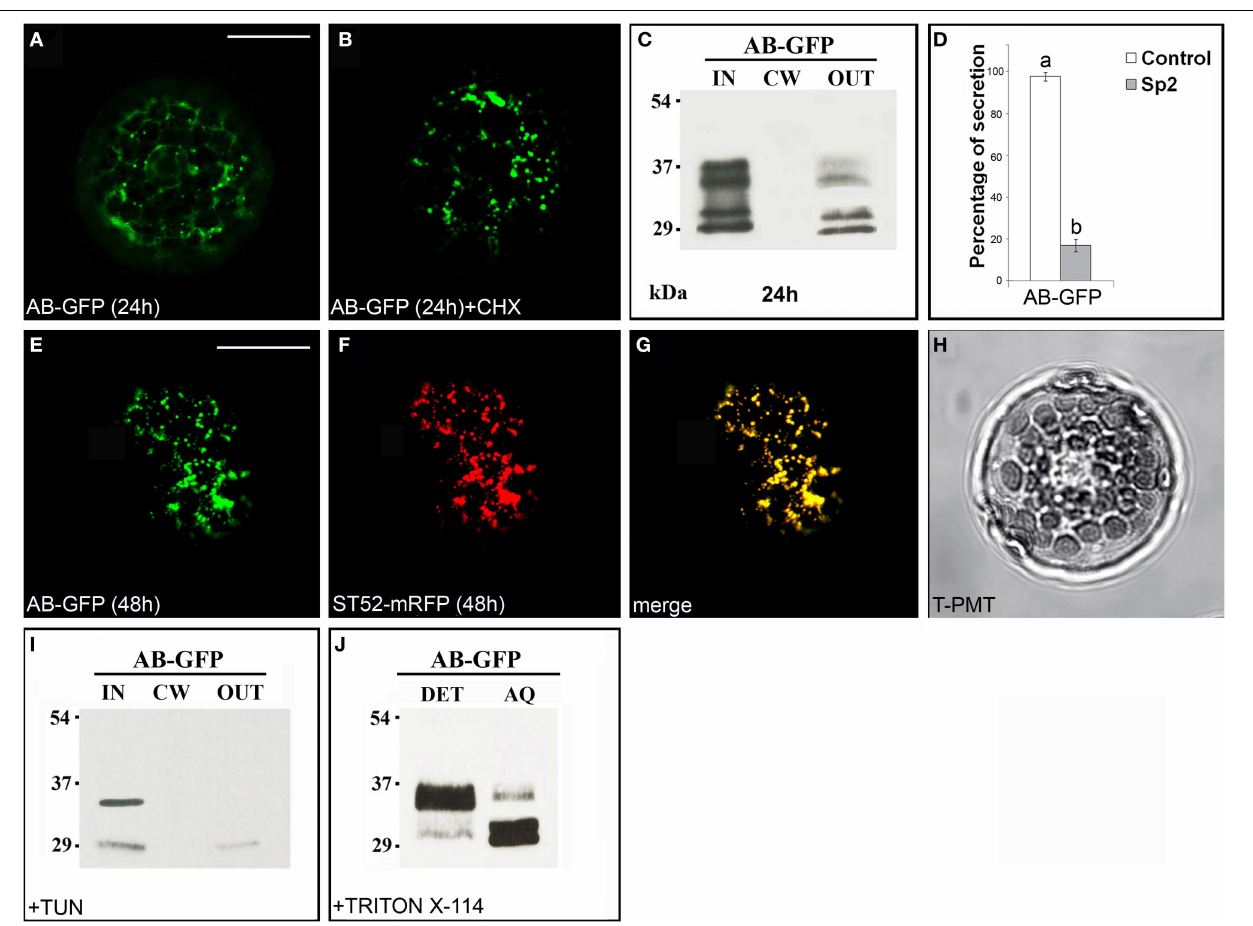
FIGURE 2 | The B domain blocks AB-GFP in the Golgi stacks. (A) Approximately 24h after transformation, AB-GFP transiently expressed in tobacco leaf protoplasts labeled ER and Golgi stacks. (B) Cycloheximide (CHX) treatment (30 µ g · mL − 1 ) of AB-GFP transformed protoplasts evidenced the final localization of the protein in the Golgi stacks. The punctate staining pattern was observed in 98 ± 2% among over 300 protoplasts examined. (C,I) Western blot analysis of protein fractions (intracellular, IN; cell wall, CW; incubation medium, OUT) obtained from AB-GFP transformed protoplasts (C) and from AB-GFP protoplasts treated with 100 µ M tunicamycin for 24h (I) . (D) Effect of Sp2 on the secretion of AB-GFP. Statistical analysis is as in Figure 1 . (E) After 48h